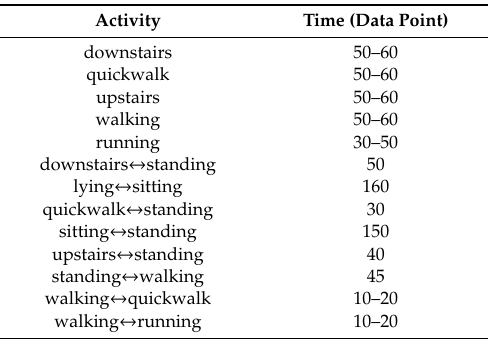
Table 2. Duration of each activity.